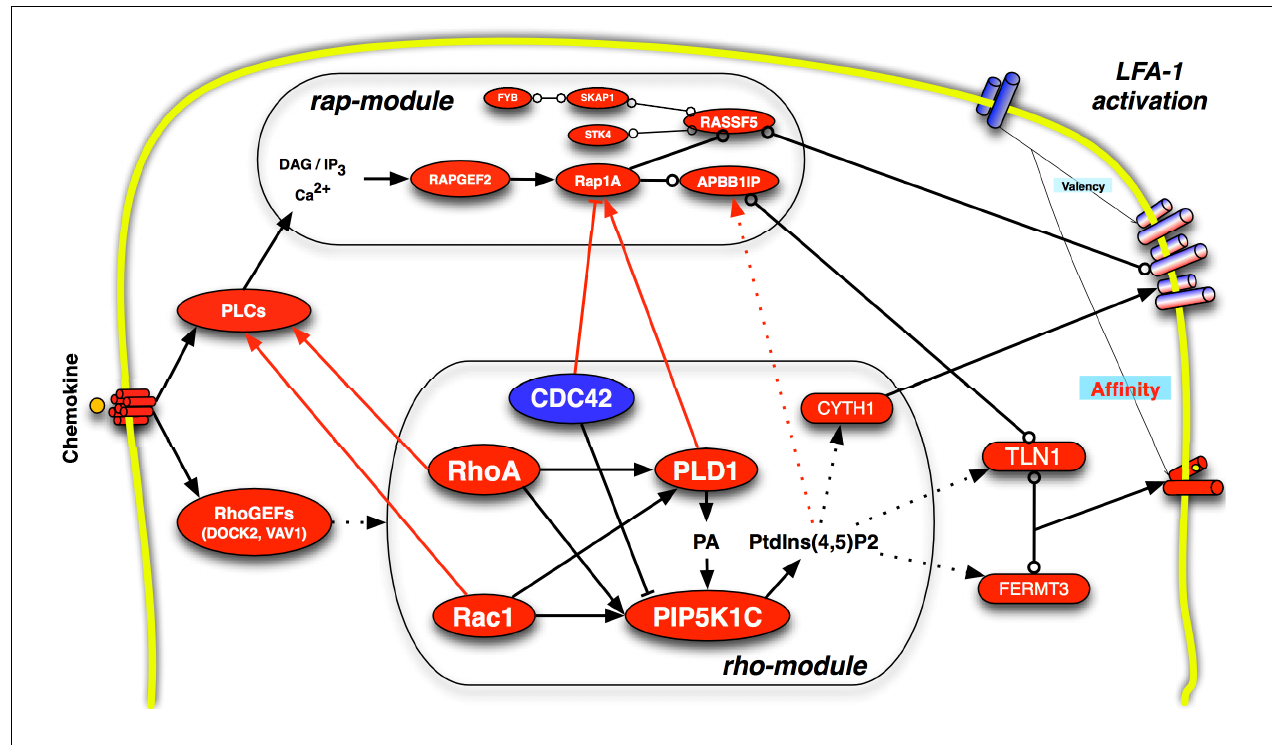
FIGURE 2 |The rap- and rho-modules of integrin affinity modulation by chemokines. The diagram mainly reports data regarding LFA-1 affinity triggering. Dotted lines refer to hypothetic effects. Red lines emphasize the functional relationships between rap and rho modules. Arrowed lines indicate activation. Flat ending lines indicate inhibition. Circle ending lines indicate docking activity. Positive regulators of adhesion are represented